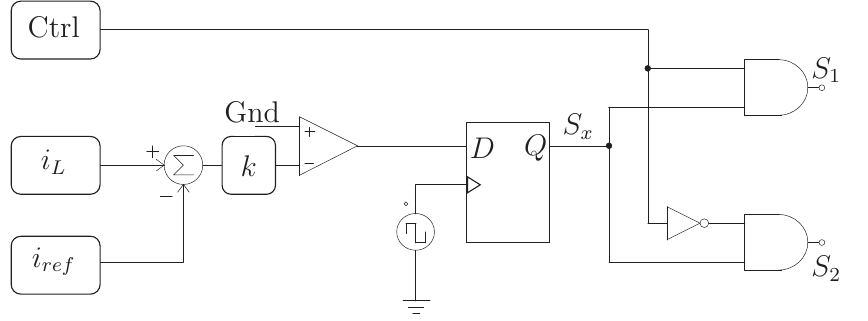
Figure 9. Low-level current